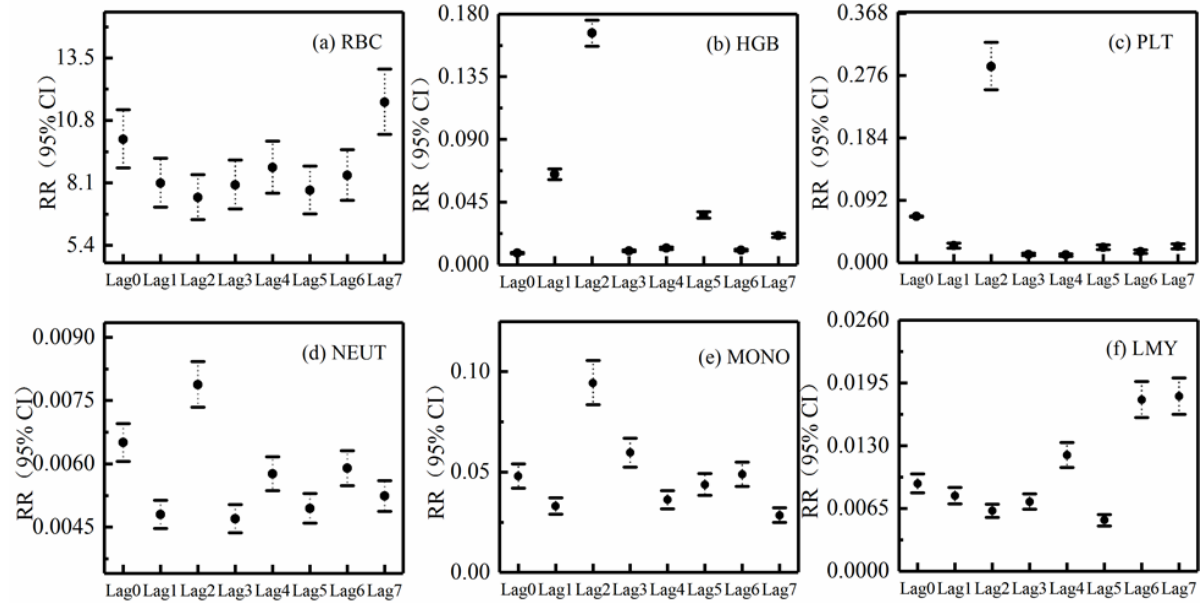
Figure 7. Effects of PM 2.5 exposure concentration on blood routine parameters in different lag conditions. RBC, red blood cell count; HGB (g/L), hemoglobin; PLT, platelet count; NEUT (%), neutrophil ratio; MONO, monocyte ratio; LMY (%), lymphatic ratio.